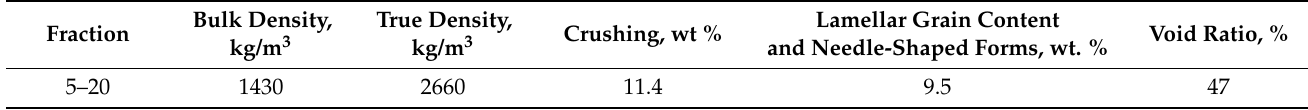
Table 3. Physical and mechanical characteristics of crushed stone.